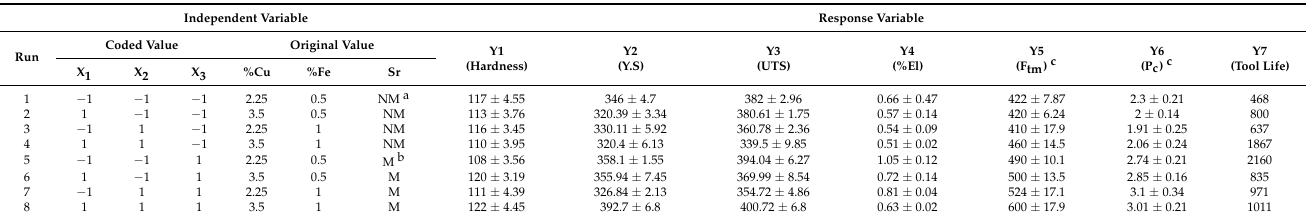
Table 4. Experimental parameters and average response variables for trial experiments (runs) used for the factorial